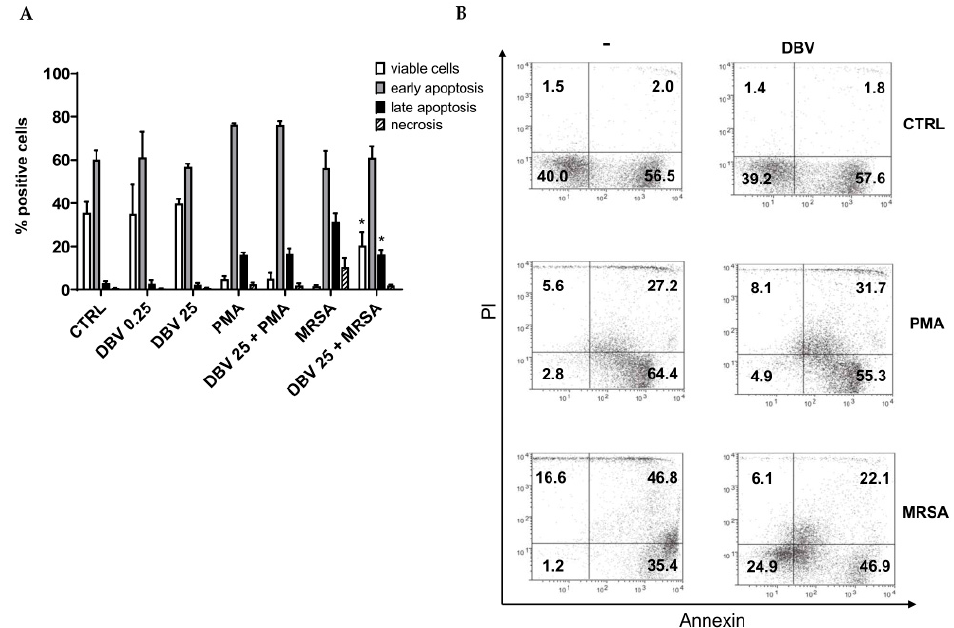
Figure 2. DBV delays the apoptosis of MRSA activated-PMNs. PMNs were untreated or treated with DBV at 0.25 and 25 μ g/mL for 60 ′ and then unstimulated or stimulated with PMA (100 nM) or MRSA (10:1) for 3 h. Cell viability was evaluated by Annexin V FITC/PI staining. ( A ) Quantitative analysis of the viable, early apoptotic, late apoptotic and necrotic cells is shown. Values are means ± SEM of at least three independent experiments. * p < 0.05 vs. MRSA-treated PMNs. ( B ) A representative dot plot experiment of PMNs pre-treated with DBV at 25 μ g/mL showing viable cells (Annexin neg/ PI neg cells, low left panel); early apoptotic cells (Annexin pos/PI neg cells, low right panel; late apoptotic cells (Annexin pos/PI pos cells, up right panel) or necrotic cells (Annexin neg/PI pos cells, up left panel) is shown. Values are means ± SEM of at least three independent experiments. * p < 0.05 vs. MRSA-treated PMNs.